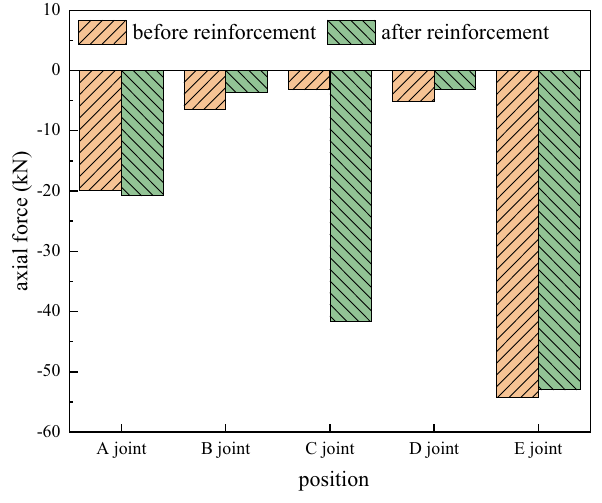
Fig. 15 The comparison of axial force